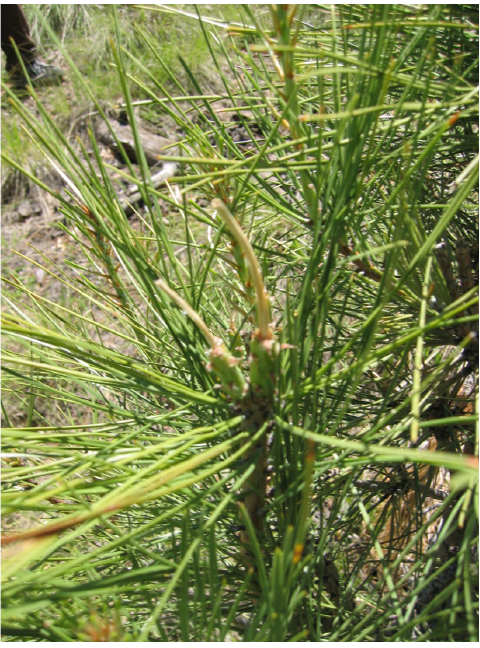
Figure 6. Typical terminal bud grazing damage on ponderosa pine seedlings caused by elk after the Dude Fire.